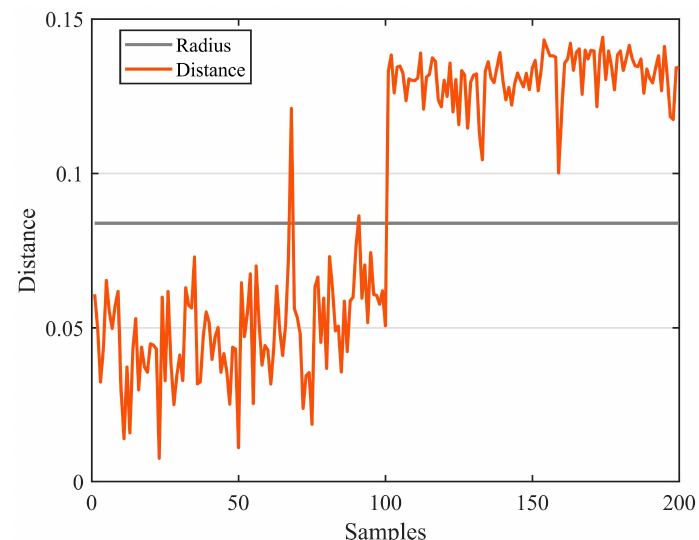
Figure 13. Testing of BO − SVDD.